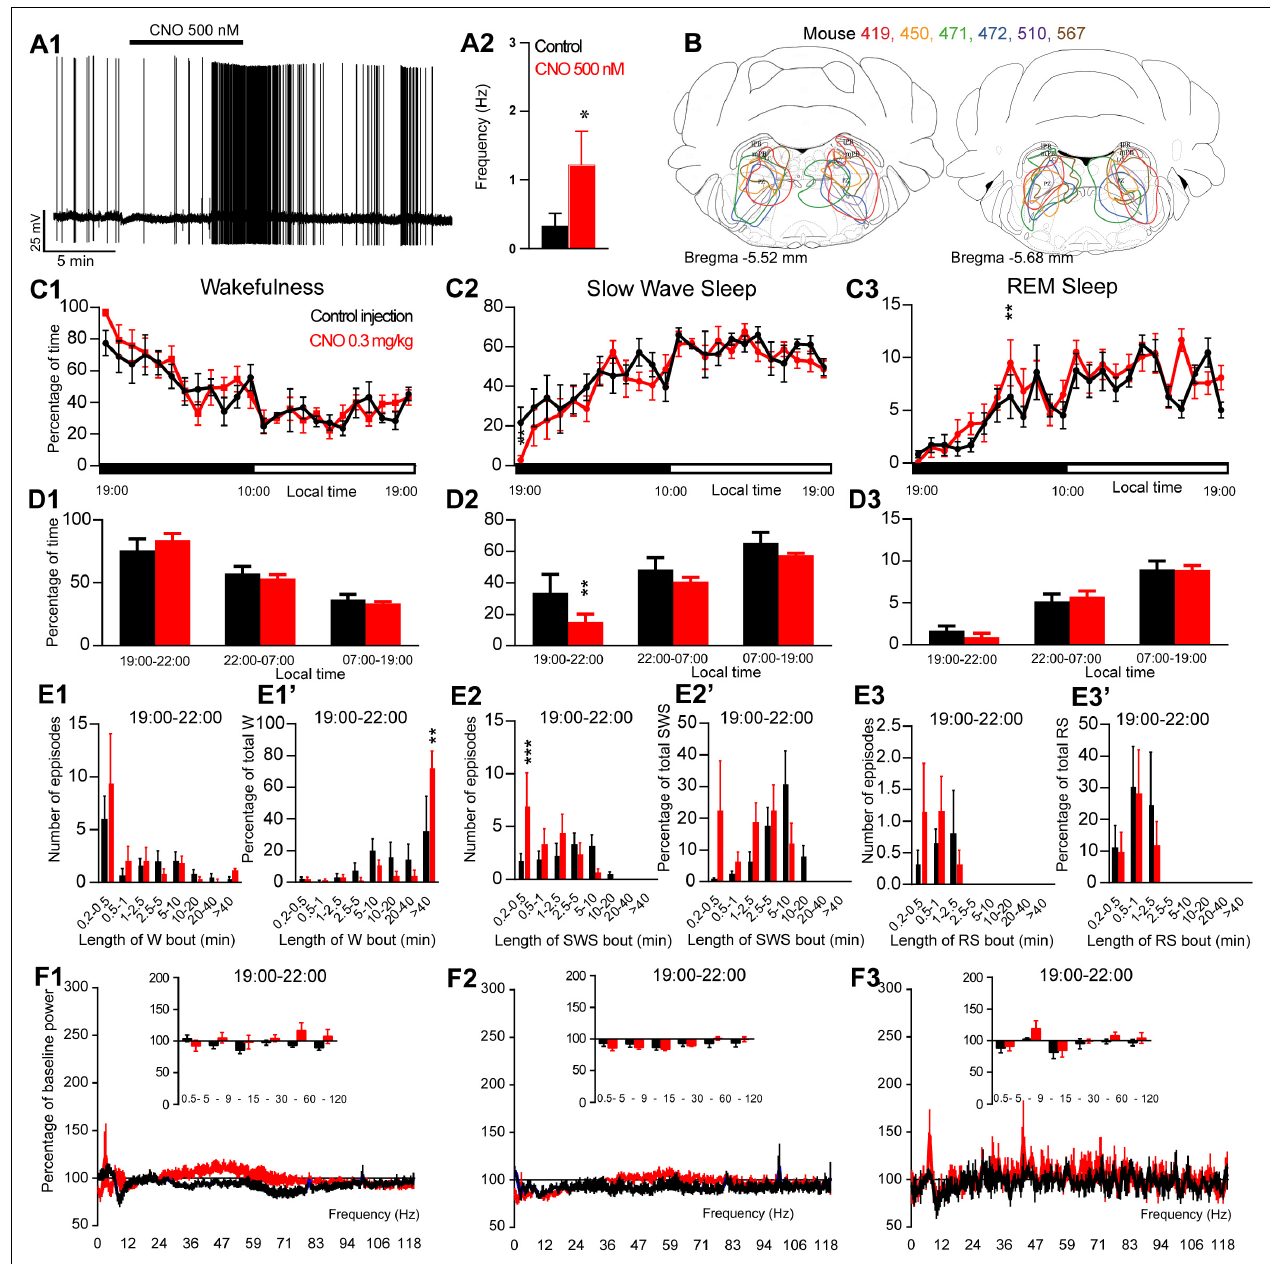
FIGURE 1 | Activation of PZ glutamatergic neurons during the active period (19:00 or ZT12). (A) In vitro confirmation. (A1) PZ Vglut2 − hM3Dq whole-cell recording showing an increase in firing frequency in response to bath application of CNO (0.5 µ M). (A2) Average firing frequency ( ± S.E.M.) during the last 2 min of the CNO (0.5 µ M) application as compared with the 2 min period preceding CNO application (control; N = 5 PZ Vglut2 − hM3Dq neurons). ∗ p < 0.05 Paired Student’s t -tests. (B) Extent of transduced neurons (mCherry-positive somas) is shown for individual Vglut2-IRES-cre mice that received bilateral injections of hM3Dq-mCherry-AAV into the PZ (PZ Vglut2 − hM3Dq ). (C) Hourly amount of wakefulness (C1) , SWS (C2) and REM sleep (C3) following CNO (0.3 mg/kg, N = 6 mice) as compared with control injection. (D1–D3) Percentage of sleep-wake states ( ± S.E.M.) during the 3 h post-injection period (19:00–22:00), the remainder (9 h) of the dark/active period (22:00–07:00) and the subsequent 12 h light period (07:00–19:00; N = 6 mice). (E1–E3) Number of episodes ( ± S.E.M.) of wakefulness (W), SWS or REM sleep (RS) in each bout length and (E1’–E3’) time-weighted frequency histograms showing the proportion ( ± S.E.M.) of W, SWS or RS amounts in each bout length as a percentage of the total amount of W, SWS or RS during the 3 h post-injection period (19:00–22:00; N = 6). (F1–F3) Sleep-wake power spectrum changes over baseline during the 3 h (19:00–22:00) post CNO (0.3 mg/kg, N = 4 mice) injection as compared with control injection; and the quantitative changes ( ± S.E.M.) in power for the δ (0.4–5 Hz), θ (5–9 Hz), α (9–15 Hz), β (15–30 Hz), low γ (30–60 Hz) and high γ (60–120 Hz) frequency bands ( ± S.E.M.) following vehicle or CNO (0.3 mg/kg, N = 4 mice) administrations. (C–F) Control injection in Black, CNO injection in red; ∗ p < 0.05, ∗∗ p < 0.01, ∗∗∗ p < 0.001, two-way ANOVA followed by a post hoc Bonferroni